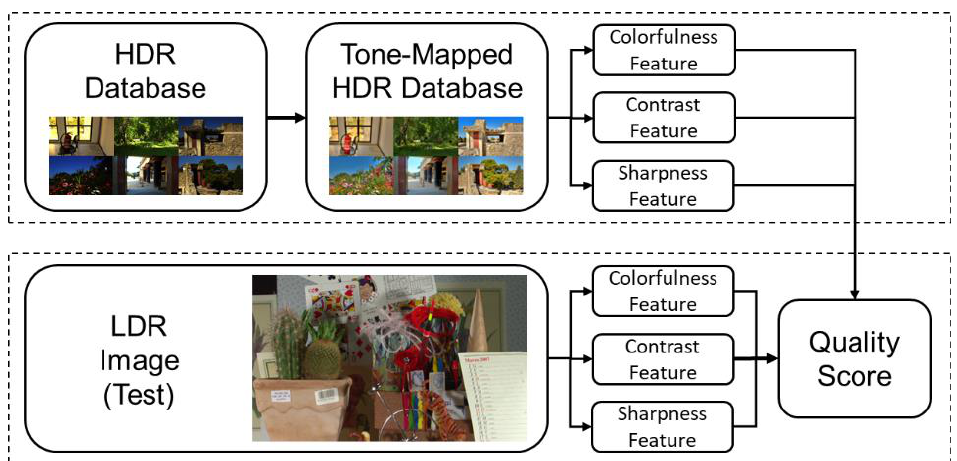
Figure 6. Diagram of the proposed method, which comprises two processes. Above side process: extracting the standard HDR-derived features. Below side process: extracting the features of the test image. These two sets of features are compared with each other to produce the final quality score of the test image.